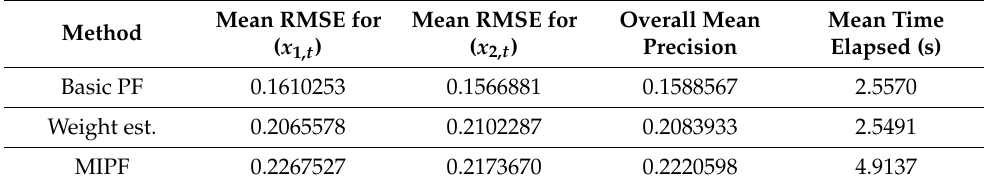
Table 1. Comparison of the results over three methods: the basic PF algorithm, when all observations are available; the weight estimation method, which is proposed in this study; and MIPF for n = 5 imputations. The methods are compared through the mean of RMSE and the time consumed over the 100 repeated